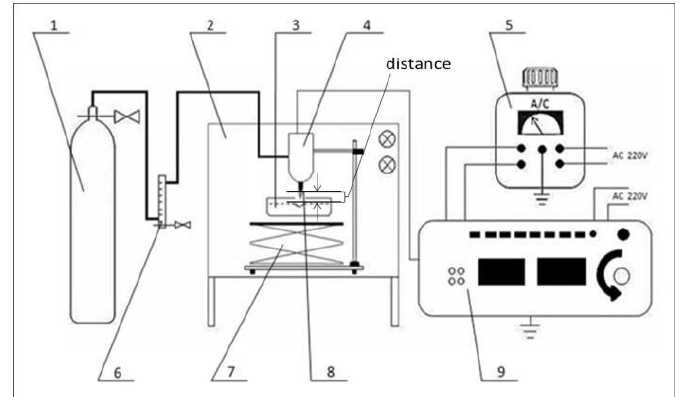
Figure 7. Schematic diagram of the experimental setup of the APLTP system. 1, argon cylinder; 2, super-clean worktable; 3, sample; 4, plasma electrode; 5, TDGC2-2 type contact voltage regulator;